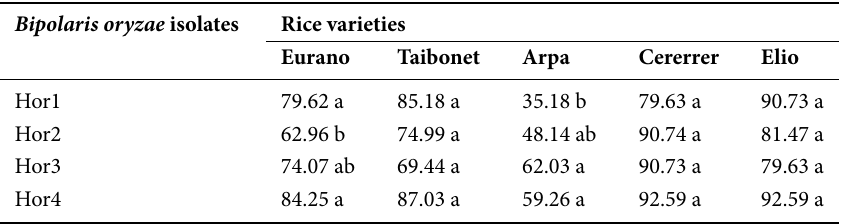
Table 6 Mean percentages of disease severity induced by Bipolaris oryzae isolates on rice